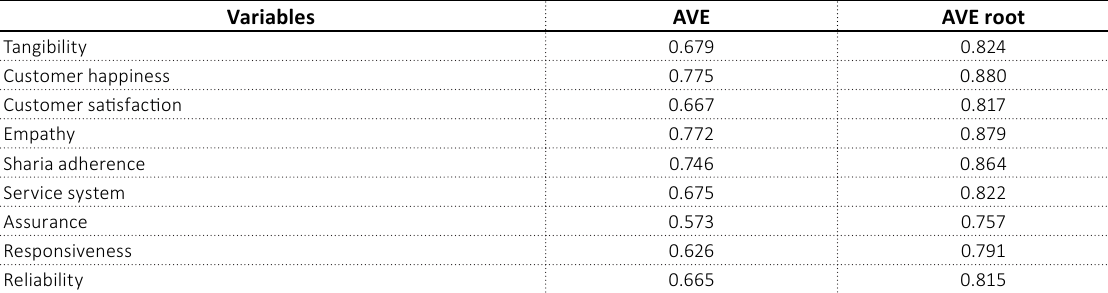
Table 3. The results of the average variance extracted test (AVE)